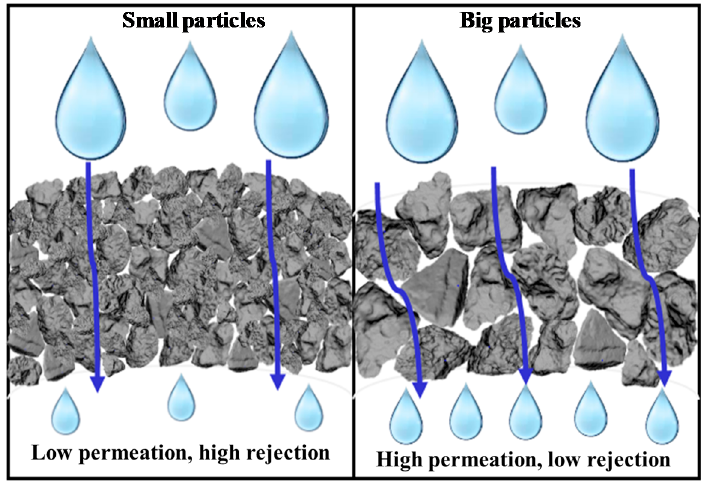
Figure 11. The illustration of the relationship between particle size, membrane compactness, water permeability, and ammonia rejection (adsorption).